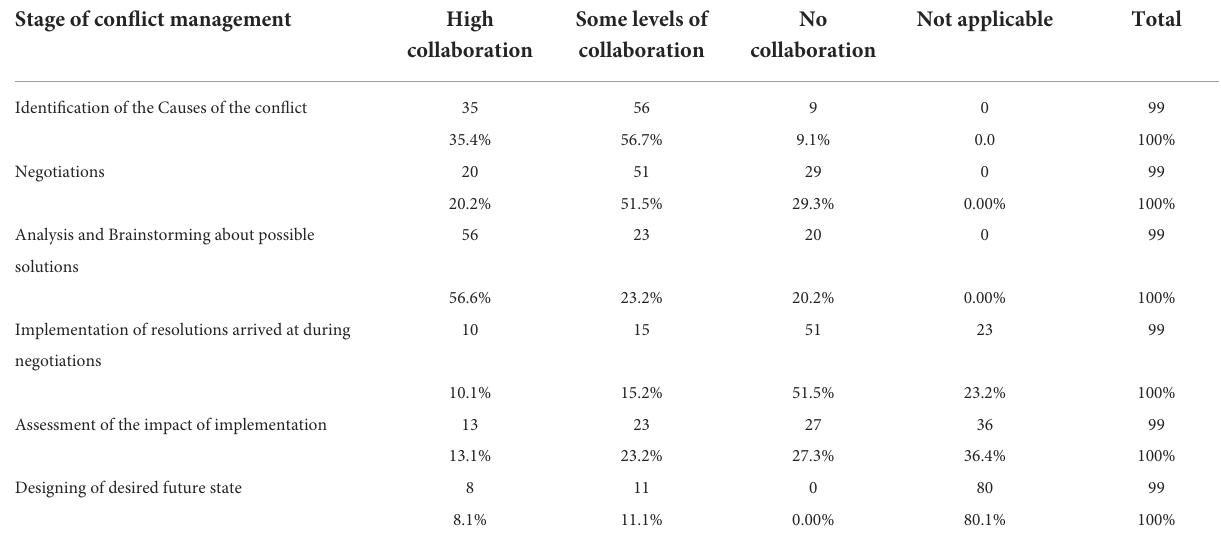
TABLE 3 Areas of collaboration between traditional and central authorities in conflict management. Stage of conflict